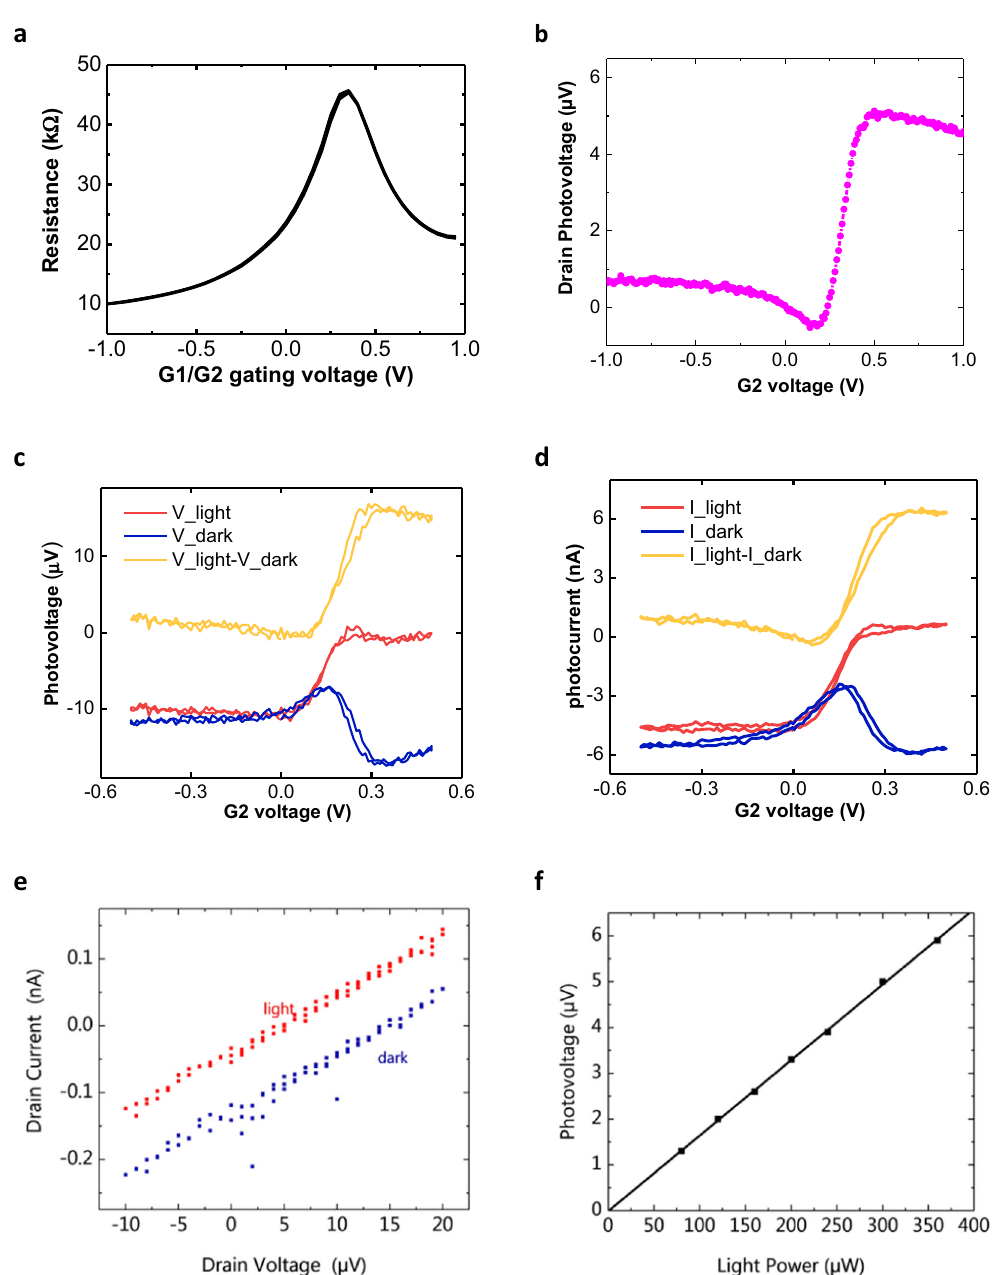
Fig. 3 Electrical mapping of light fi eld in a plasmonic slot waveguide. a The resistance of graphene as a function of the gate voltage applied to both G1 and G2 contacts for a sample with a 30 nm HfO 2 dielectric layer. b A photovoltage measured between the source and drain of graphene as a function of the gate voltage G2 when the contact G1 is grounded. The photovoltage was measured with an optical chopper and lock-in ampli fi er. c A photovoltage (drain voltage in open circuit) and d a photocurrent (drain current in a short circuit) as a function of the gate voltage G2 with and without light input through the waveguide, measured directly with a source metre. Both the source and the G1 contact were connected to the ground. e Dependence of the photocurrent on the drain bias voltage of graphene with and without illumination. Both source and G1 are connected to ground, and 0.4 V gate voltage is applied to G2. f Linear dependence of the photovoltage on the incident light power with a fi xed gate voltage of 0.4 V applied to G2 and G1 contact being grounded. The data for a , b and c – f were measured on two different samples with the same